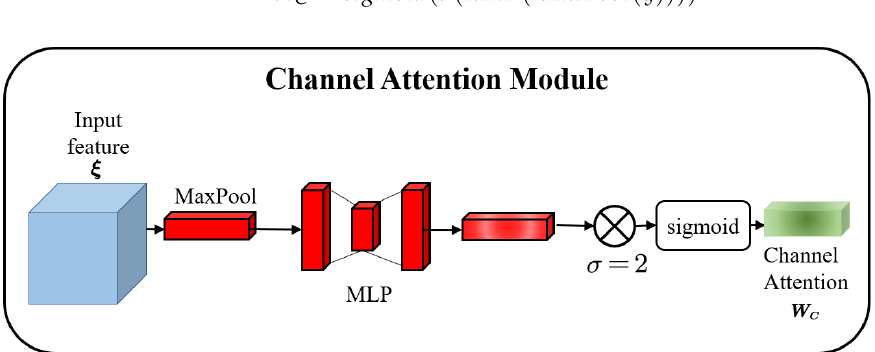
Figure 6. Diagram of the channel attention module.